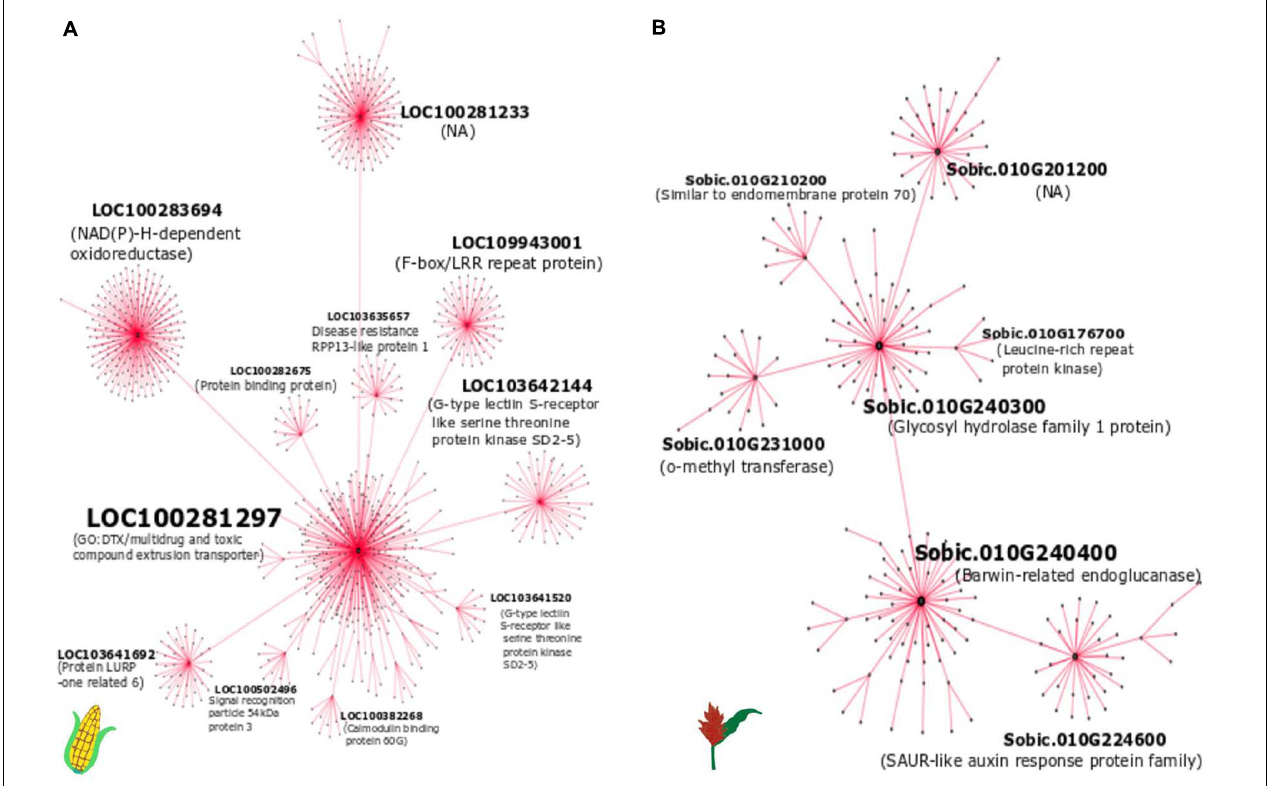
FIGURE 6 | The weighted gene co-expression network of (A) maize module 6 and (B) sorghum module 11. The hub genes (present at the center) that are connected to other genes in each sub-network are labeled.